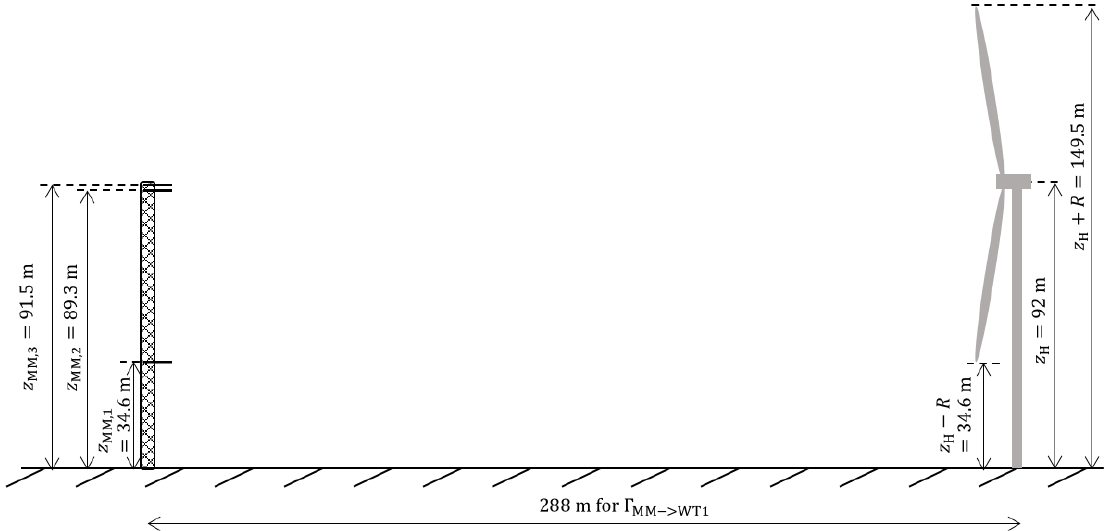
Figure 3. Sketch (to scale) of met mast and WT1 with relevant dimensions.